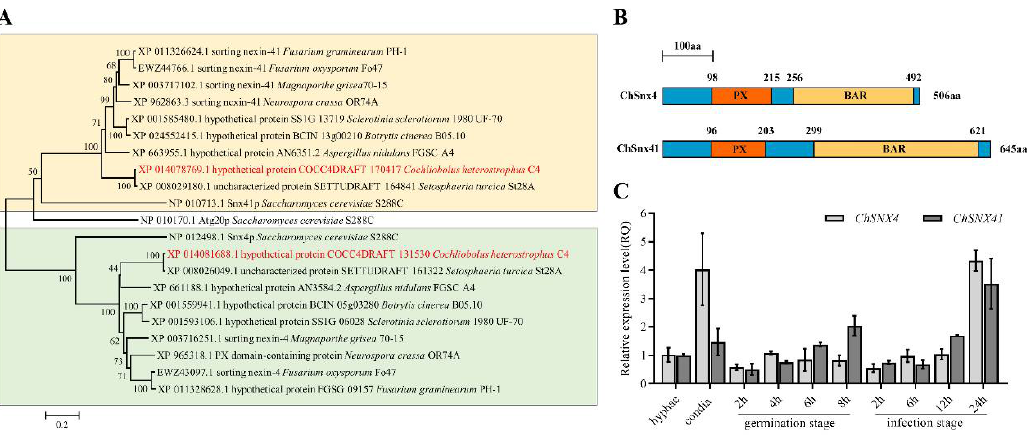
Figure 1. ( A ) Phylogenetic analysis of Snx4 and Snx41 in different organisms. The amino acid sequences of C. heterostrophus , S. cerevisiae , A. nidulans , S. turcica , F. oxysporum , F. graminearum , M. oryzae , B. cinerea , and S. sclerotiorum were used to construct the phylogenetic tree with the MEGA 6 program. ( B ) The information on the PX (phox homology) and BAR (Bin/Amphiphysin/Rvs) domains of ChSnx4 and ChSnx41. ( C ) Relative expression levels of ChSNX4/ChSNX41 during different developmental stages; each experiment had three replicates and was repeated three times.